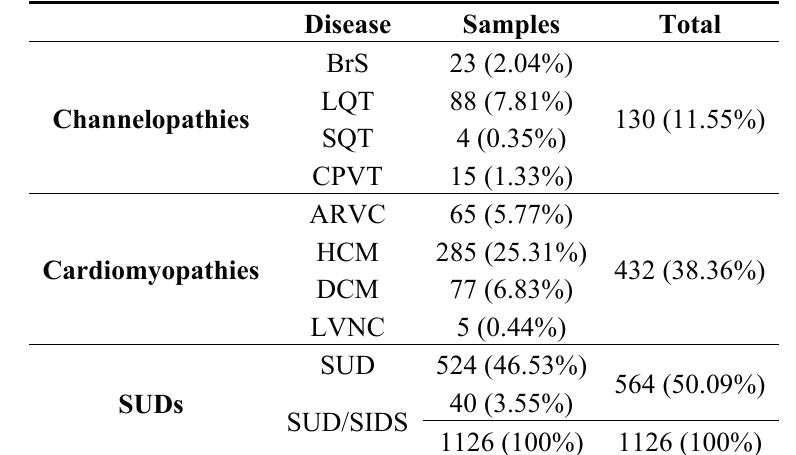
Table 1. Samples included in our cohort of study. The SUDs group represents around 50% of all samples. Regarding live patients, around 25% correspond to